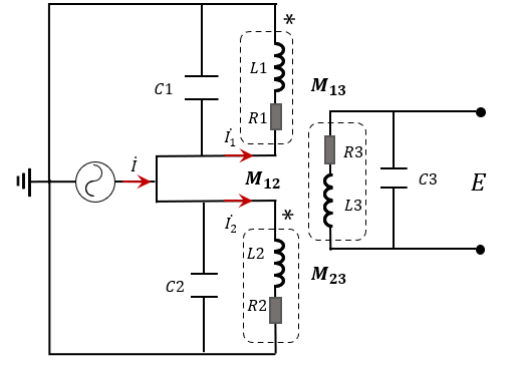
Figure 2. Equivalent circuit diagram of three coils.